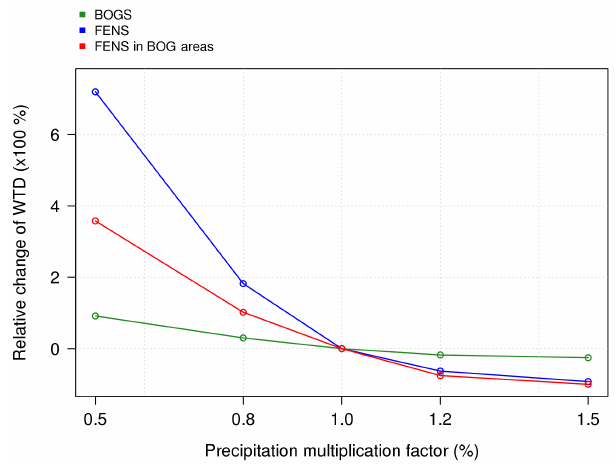
Figure 8. Relative change of water table position of peatlands in August as a function of precipitation multiplication factor ranging from 0.5 to 1.5 depending on the type of peatlands: minerotrophic (FENS), ombrotrophic (BOGS) and minerotrophic in regions local- ized as ombrotrophic (FENS in BOGS